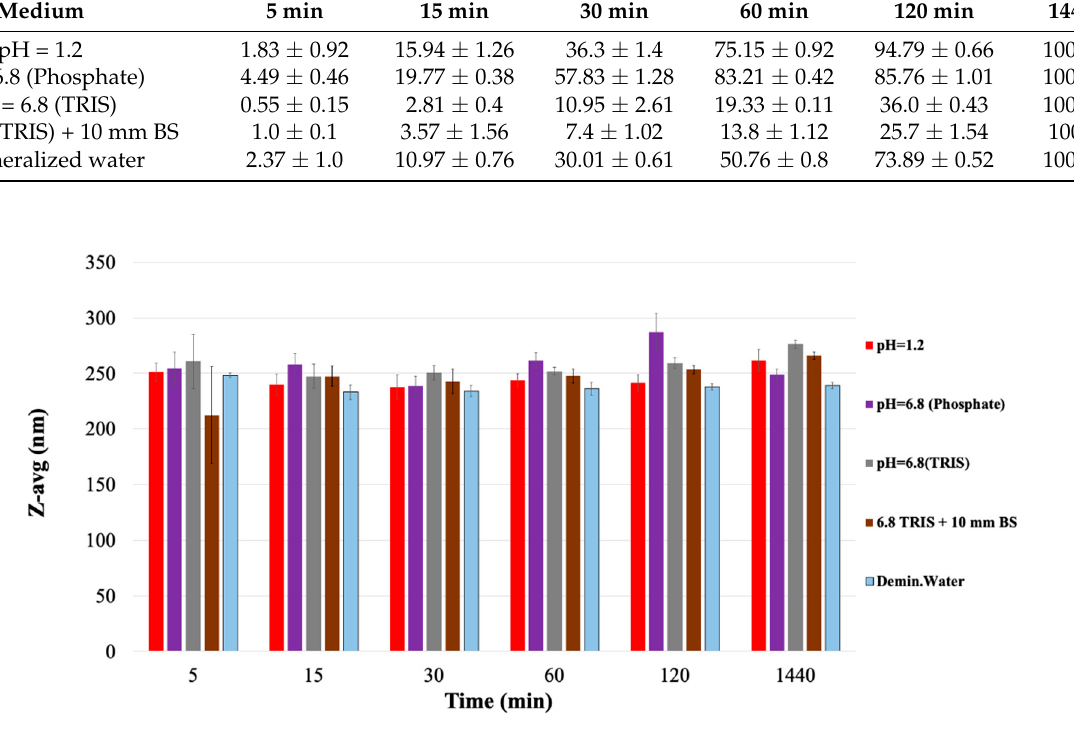
Figure 5. Particle size of dissolution sample (carrier = PVA; n = 3; mean ± SD).